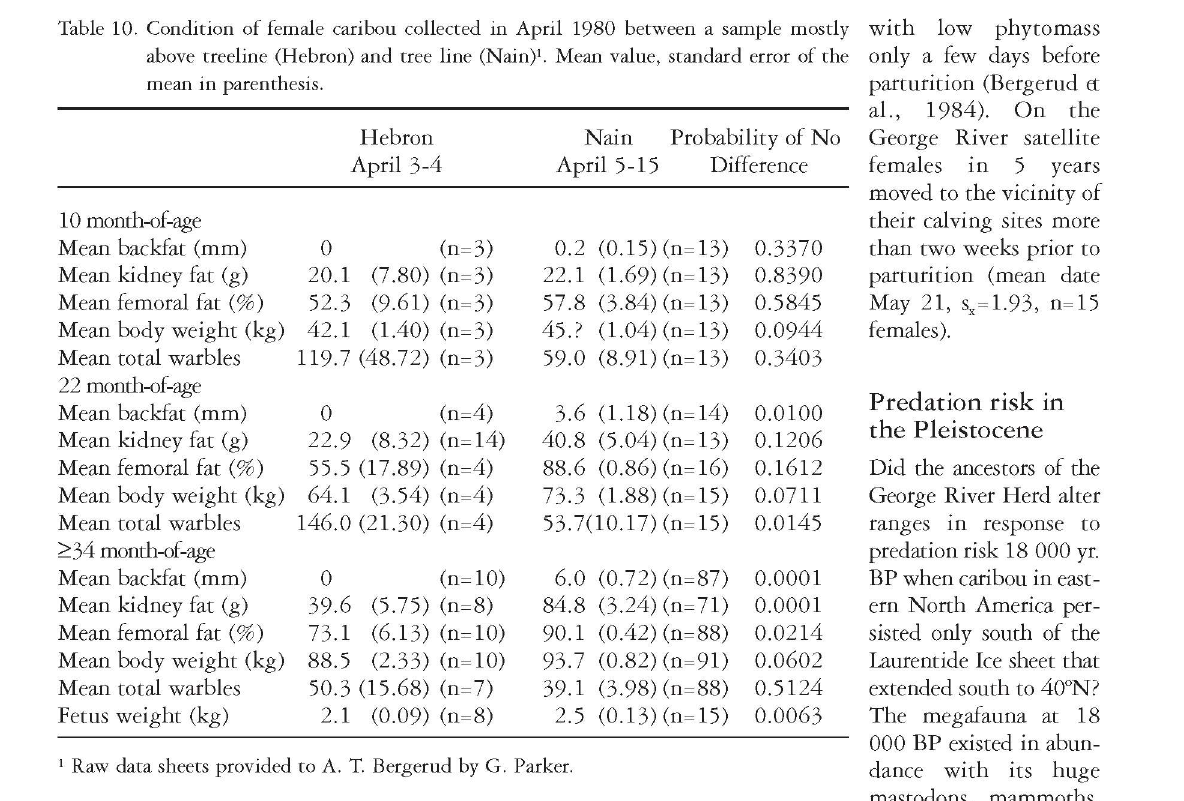
Table 10. Condition of female caribou collected in April 1980 between a sample mostly above treeline (Hebron) and tree line (Nain) 1 . Mean value, standard error of the mean in